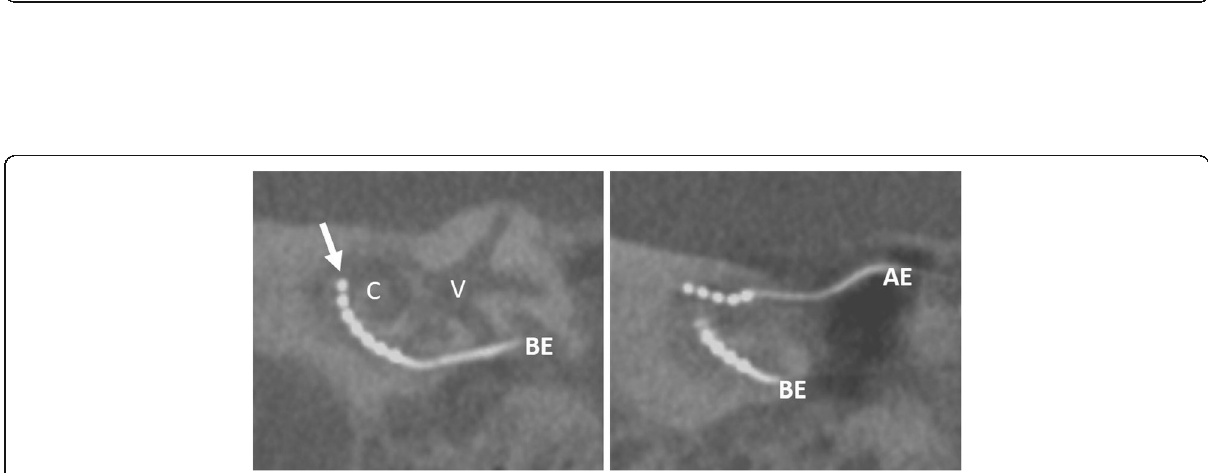
Fig. 20 A 15-year-old male patient, with normal postoperative finding after CI surgery. CBCT paracoronal image (left image) shows an electrode array located in the scala tympani (lower segment) of the cochlear duct (white arrow). BT – basal turn. MT – middle turn. AT – apical turn. CBCT paraaxial image (right image) shows the most basal electrode contact for this type of implant correctly located 3 mm below the round window